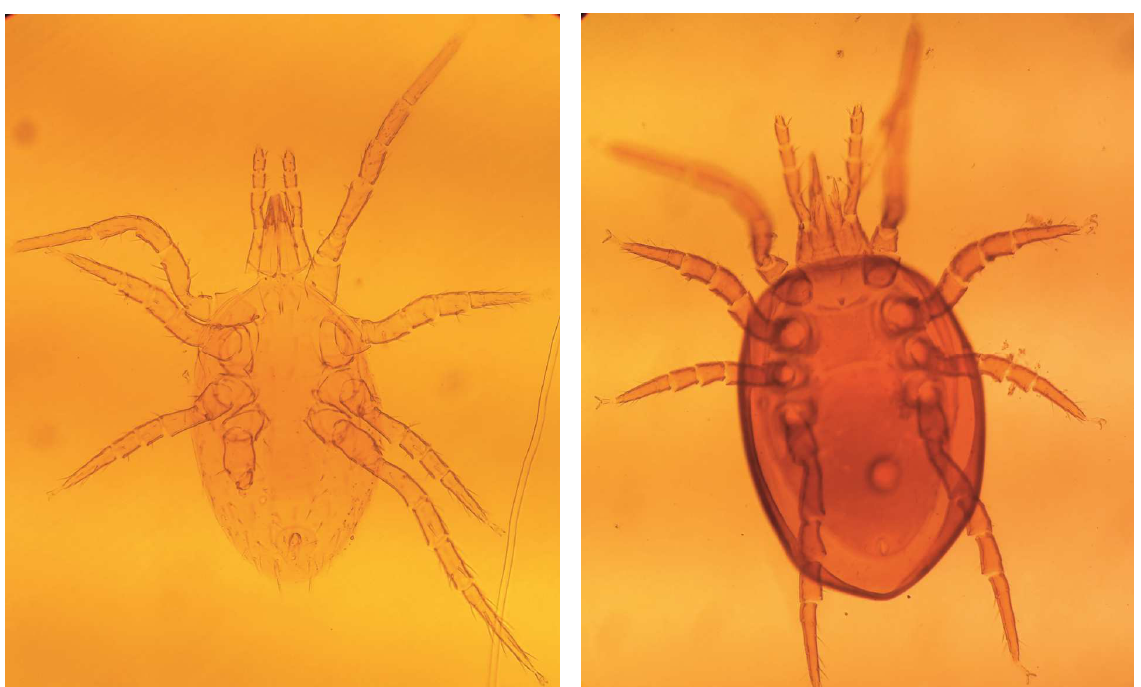
F IGURE 1. Cosmolaelaps malakutsilyus Rosario, 1981 F IGURE 2. Ololaelaps sellnicki Bregetova and Koroleva,